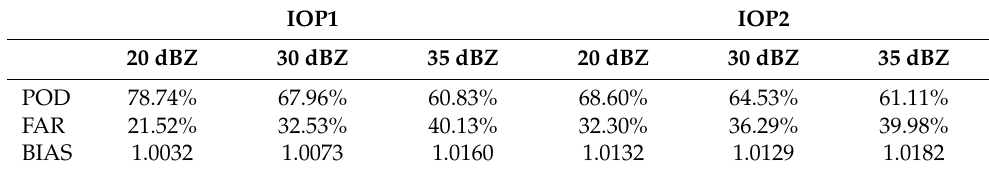
Table 2. Statistical indices by thresholds during the IOPs for the algorithm in adaptive